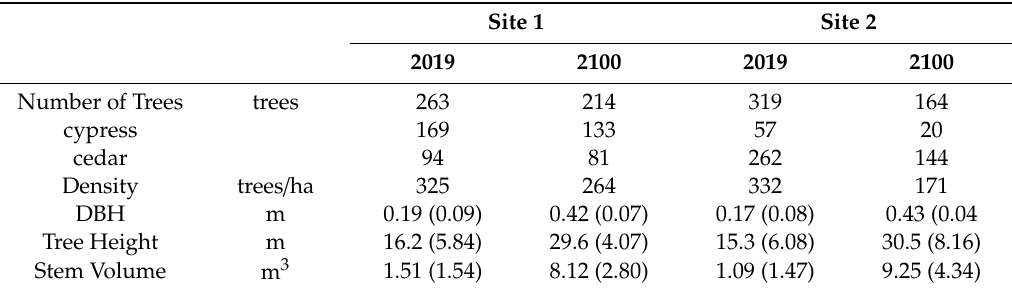
Figure 13. Visualization of the temporal and spatial explicit stem volume changes. The X and Y axis denote the coordination of individual trees, and the Z axis indicates the tree height. The bubble size and color depth represent the stem volume of the individual tree. Table 6. The results of carbon stock simulation. Values for DBH, tree height, and stem volume represent mean values within the sites. Values in brackets denote standard